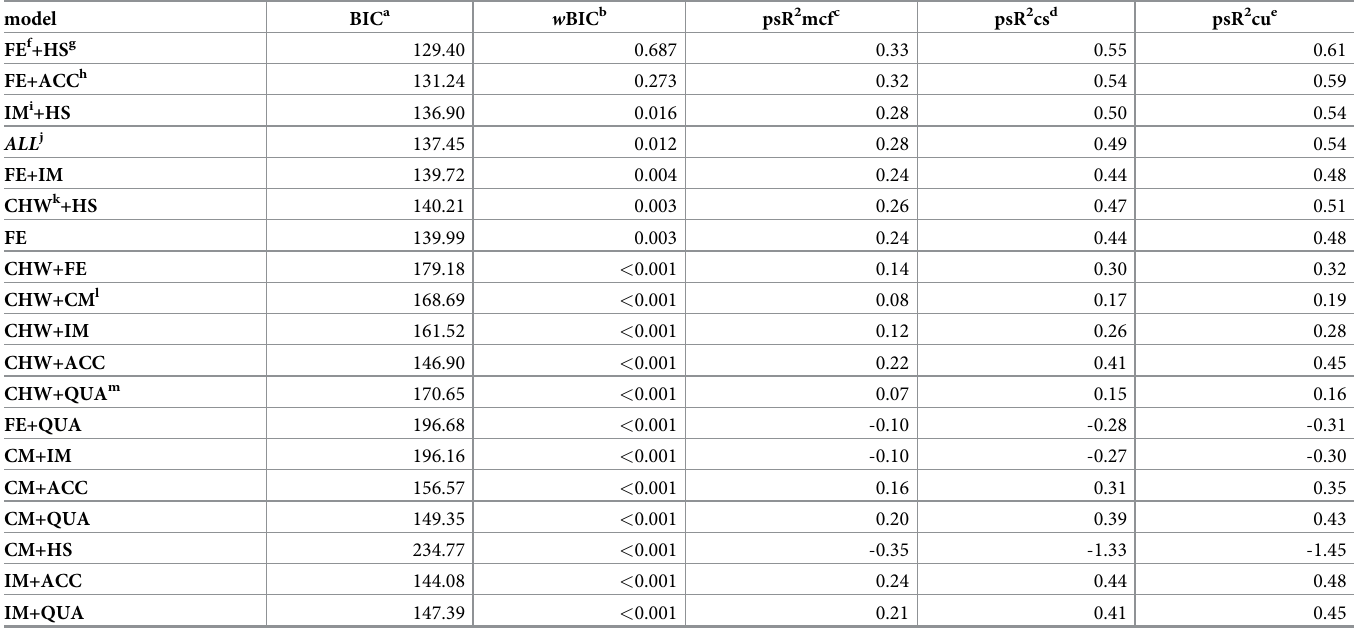
Fig 3. Predicted fertility as a function of variation in infant mortality (raw data from 64 countries for which both variables were available superimposed onto boosted regression tree relationship). Once infant mortality has exceeded a threshold of approximately 0.0282 (28.2/1000 live births), fertility increases precipitously. Country codes provided in Fig 1. https://doi.org/10.1371/journal.pone.0280260.g003 Table 3. General least-squares models of the highest-ranked variable from each theme ( i . family-planning availability, ii . family-planning quality, iii . education, iv . religion, v . mortality, vi . socio-economics) in relation to variation in fertility among 64 low- and middle-income